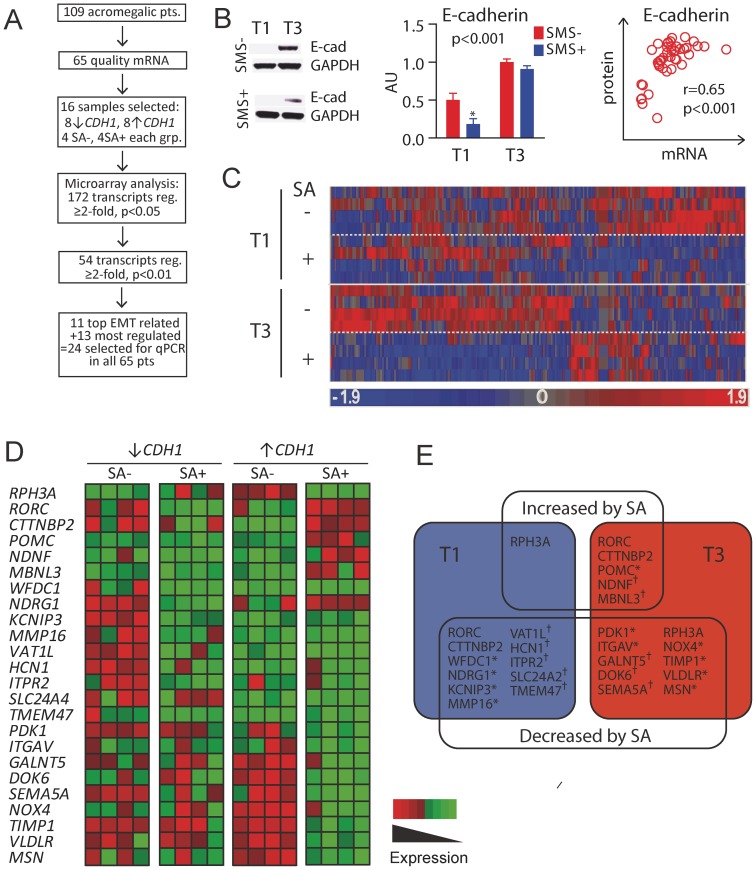
Study designs.(A) Overall study design. (B) Western blot of E-cadherin and GAPDH. Data for the E-cadherin protein ratio presented in the adenomas from E-cadherin gene expression tertile 1 and tertile 3. Correlation plot between E-cadherin protein and mRNA levels. (C) Gene expression profiles of differentially expressed genes in 16 adenomas selected from low and high tertiles of E-cadherin expression; 4 adenomas in each tertile were pretreated with SA. Gene expression levels for each adenoma are presented in horizontal rows with colors indicating upregulated (red) or downregulated (blue) genes. A total of 172 genes were differentially expressed in response to SA; 57 were downregulated and 1 was upregulated in tertile 1, while 93 were downregulated and 22 were upregulated in tertile 3 (mean fold change ≥2.0 and p<0.05). Each column represents a single gene. (D) A more detailed gene expression profile is presented for the 24 selected transcripts. The color intensity represents the degree of regulation; green indicates downregulation, while and red indicates upregulation. (E) Regulated SA transcripts presented. Transcripts were selected based on their known association with EMT or E-cadherin (*) or were chosen because of their strong regulation by the different levels of E-cadherin expression and by SA (†) (mean fold change ≥2.0 and p<0.01).